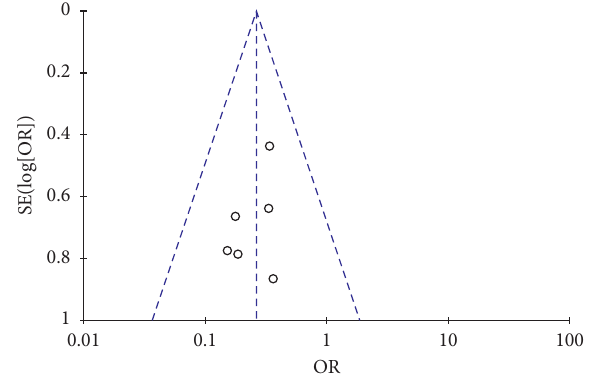
Figure 3: Funnel plot of standard error by log odds ratio. Ab- breviations: SE, standard error; OR, odds